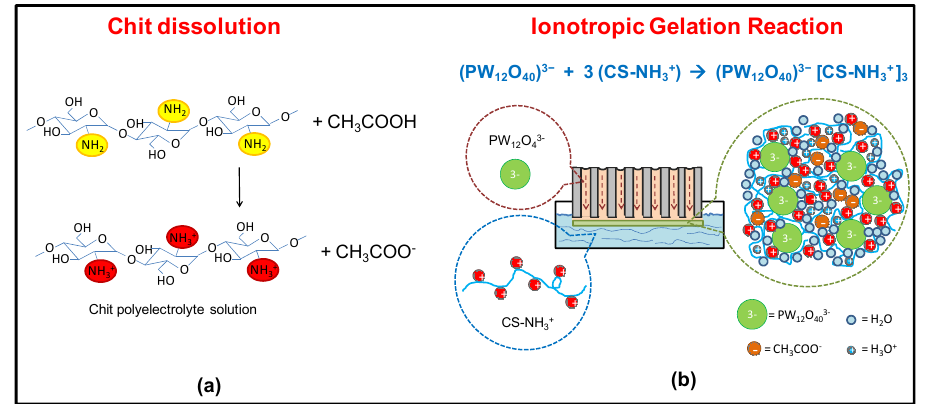
Figure 2. Scheme of the ( a ) chitosan polyelectrolyte formation in acetic acid; and ( b ) in-situ ionotropic gelation of chitosan through cross-linking with PWA 3 − anions on AAM flat substrate (BIG method, step 4 of Figure1c).